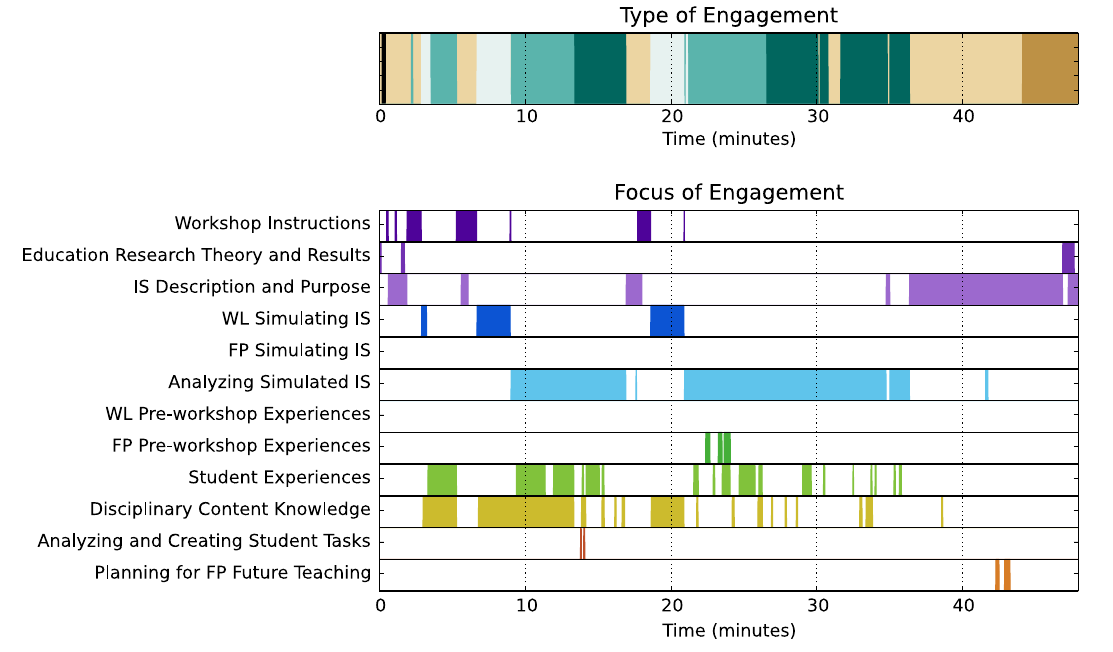
FIG. 4. Time line representations of the R-PDOT data for session C